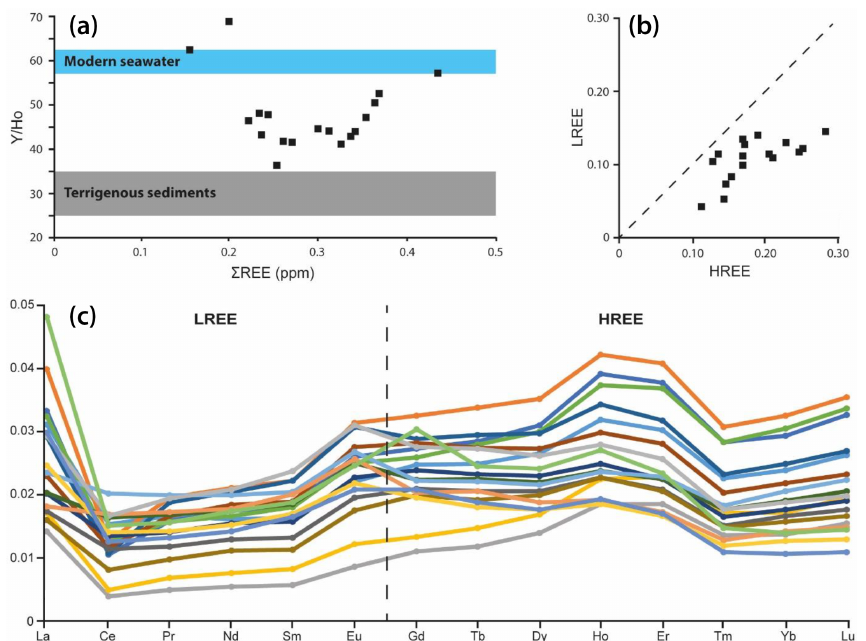
Figure 7. The Y / Ho diagram (a) for terrigenous influence, the ratio of light rare earth elements (LREEs) to heavy rare earth elements (HREEs) (b) , and the REE patterns (c) to check for a normal marine pattern with elevated HREEs compared to